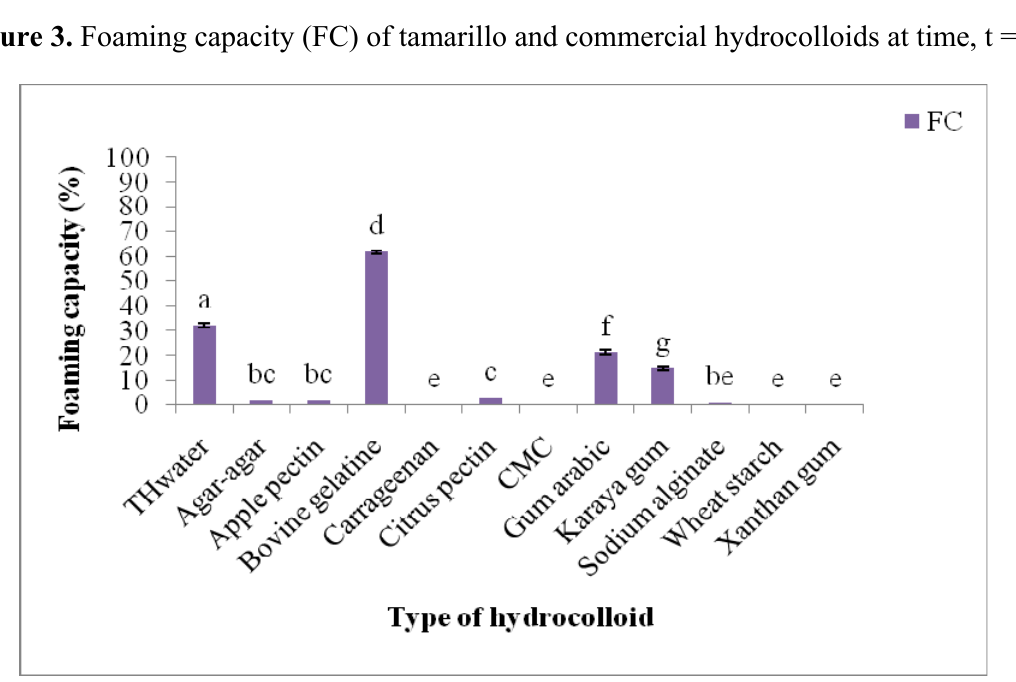
Each value is expressed as mean ± standard deviation (n = 3) of triplicate analysis. a–g Means followed by different superscript lowercase letters indicate significant differences ( p <